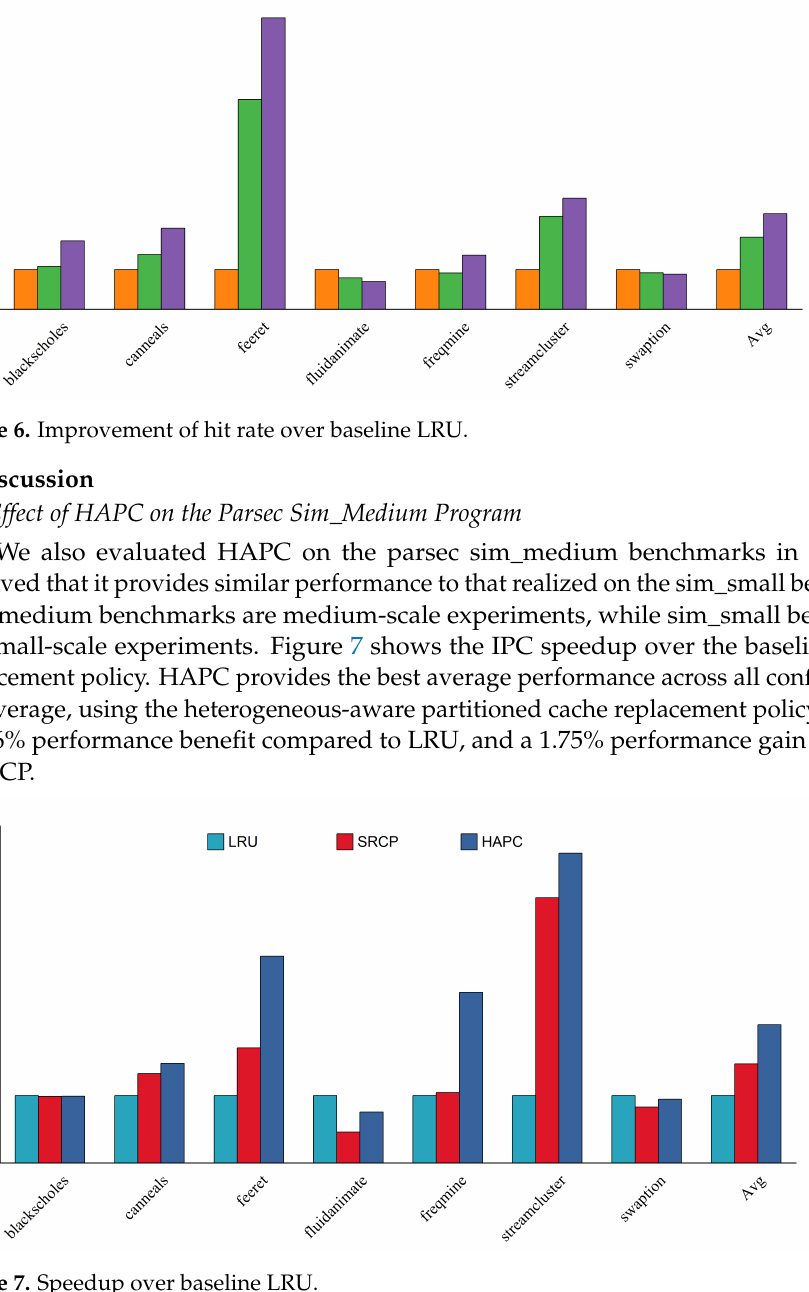
Figure 7. Speedup over baseline